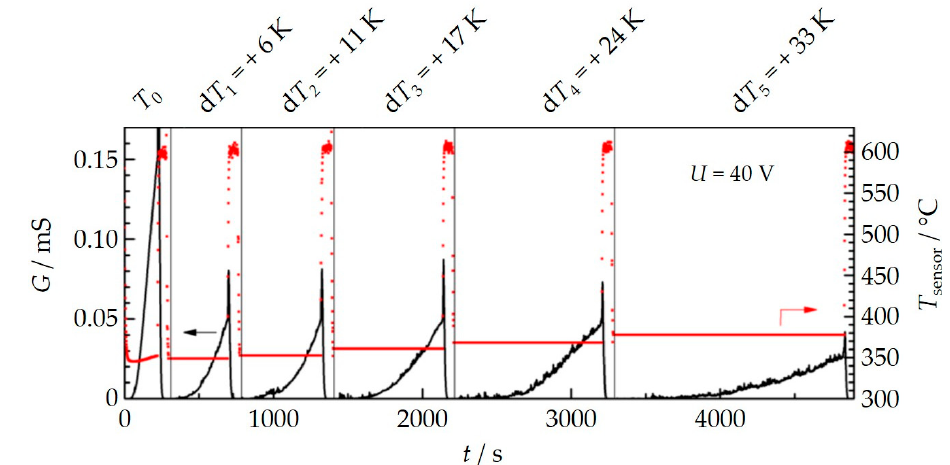
Figure 8. Conductance G for several soot deposition cycles at U IDE = 40 V during constant engine operation. After regeneration, an additional small power was applied to the sensor to establish a slightly higher temperature of the sensor tip compared to the exhaust temperature. This temperature difference d T = T sensor − T exhaust that was kept constant during each soot deposition phase.